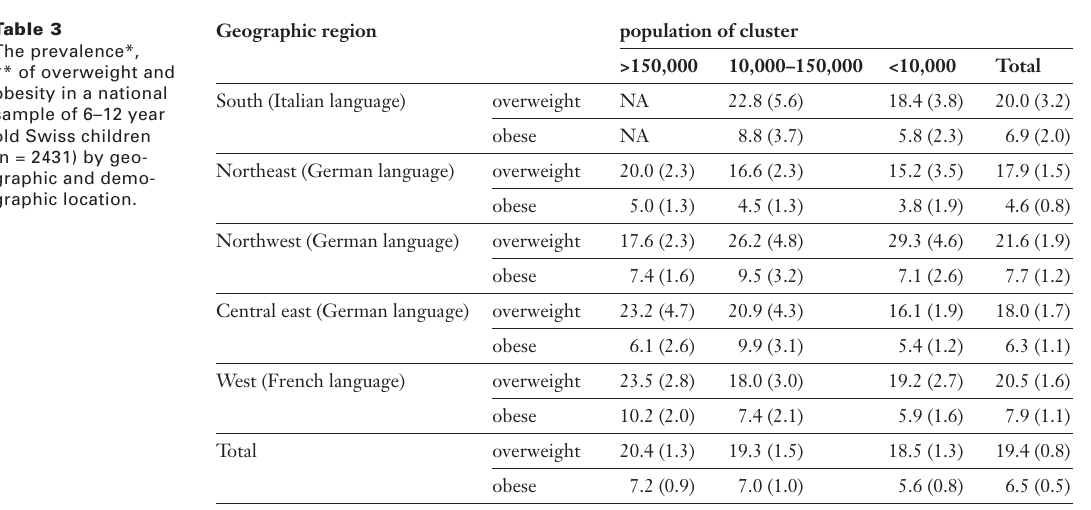
Table 4 Body fat percentage* in Swiss children in the 1st Zurich Longi- tudinal Study [28], the 2nd Zurich Longi- tudinal Study [29] and the present study by age and